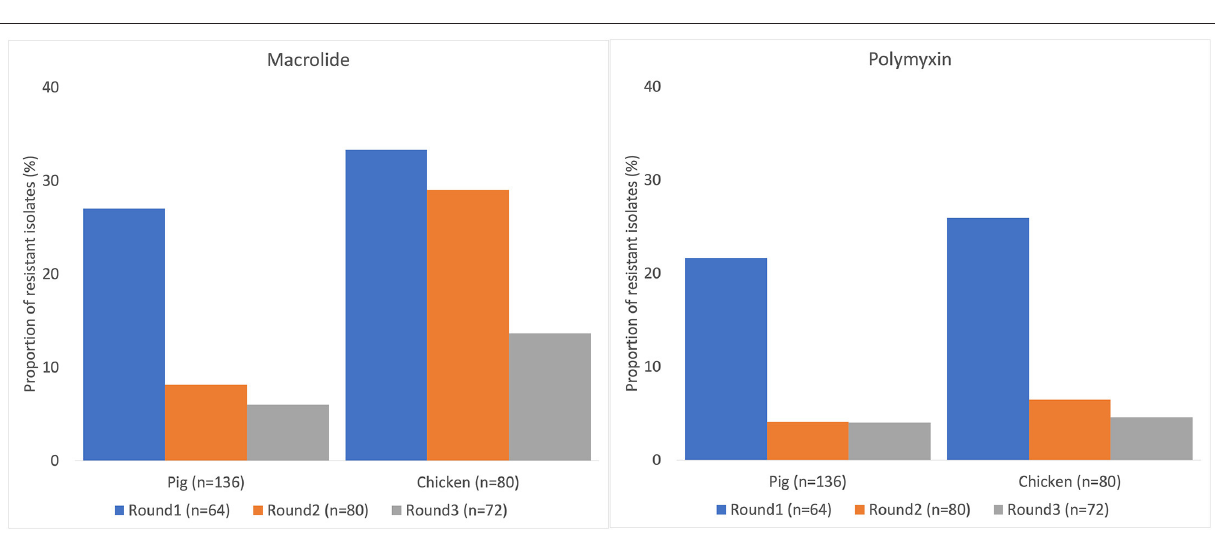
FIGURE 4 | Decreasing trend of non-typhoidal Salmonella resistance to macrolide and polymyxin in pig and chicken samples collected from five provinces in Vietnam,